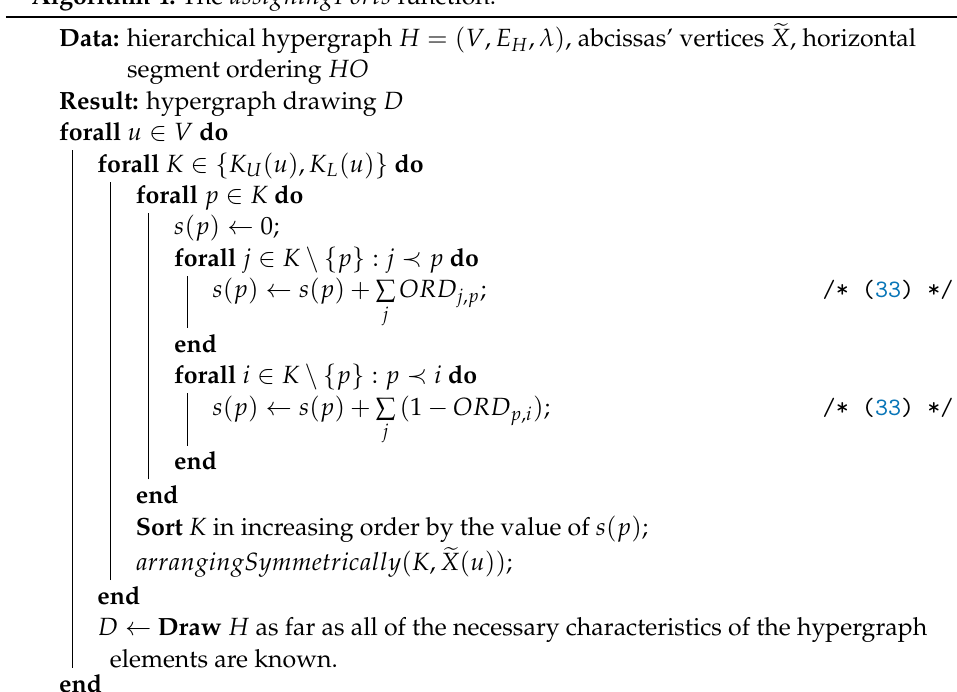
Algorithm 4: The assigningPorts